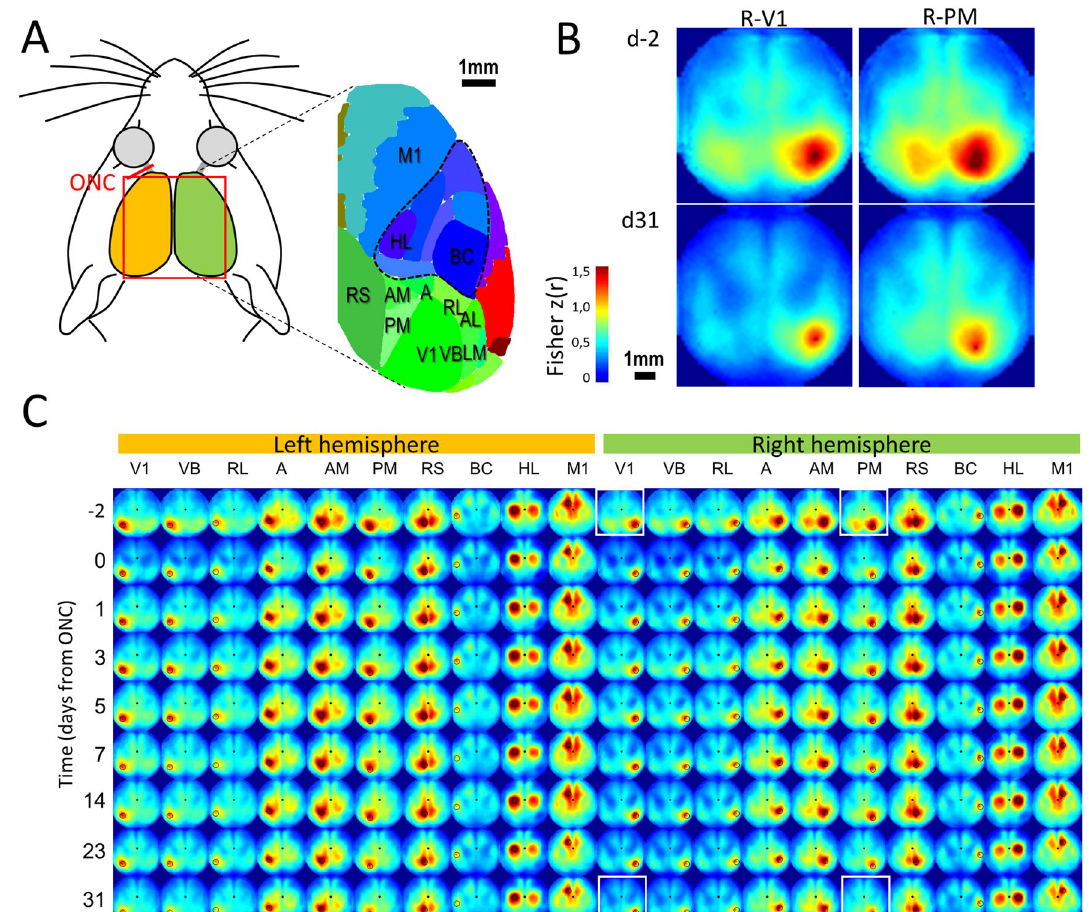
Figure 3. Seed pixel correlation mapping during resting state. Resting state spontaneous activity was band pass filtered. To create seed pixel correlation maps, the cross correlation coefficient r values (represented in color) between the temporal profiles of one selected pixel and all the others of the ROI were calculated. ( A) Schematic of the murine cortical regions imaged in the present mapping. ( B) Representative examples of seed pixel correlation maps (averaged from n = 9 mice and Fisher Z-transformed) for seed pixels localized in right areas V1 and PM before ONC (baseline, d-2) and 31 days after (these four examples correspond to the images within the four white squares in C ). ( C) Averaged seed pixel correlation maps of 20 different locations (black circles) before and after the ONC (y-axis, d-2 to d31). Correlation values were Fisher Z-transformed and displayed between z = 0 and z = 1.5 corresponding approximately to r = 0.91. V1 primary visual cortex; A, AM, PM, LM, RL anterior, anteromedial, posteromedial, lateromedial and rostrolateral regions of the secondary visual cortex; AC